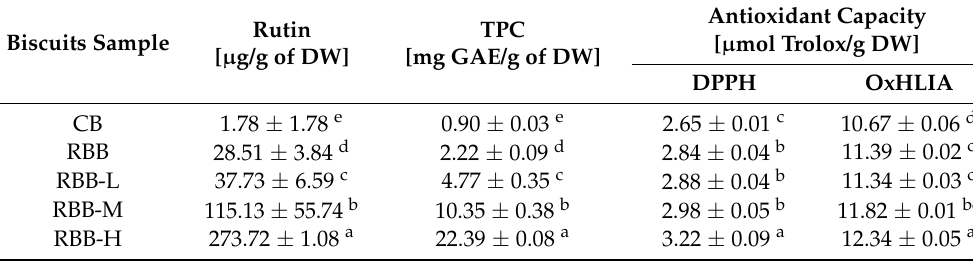
Table 1. Rutin and Total Phenolic Compounds (TPC) contents and antioxidant capacities of rye-buckwheat biscuits enriched with rutin as determined by DPPH and OxHLIA